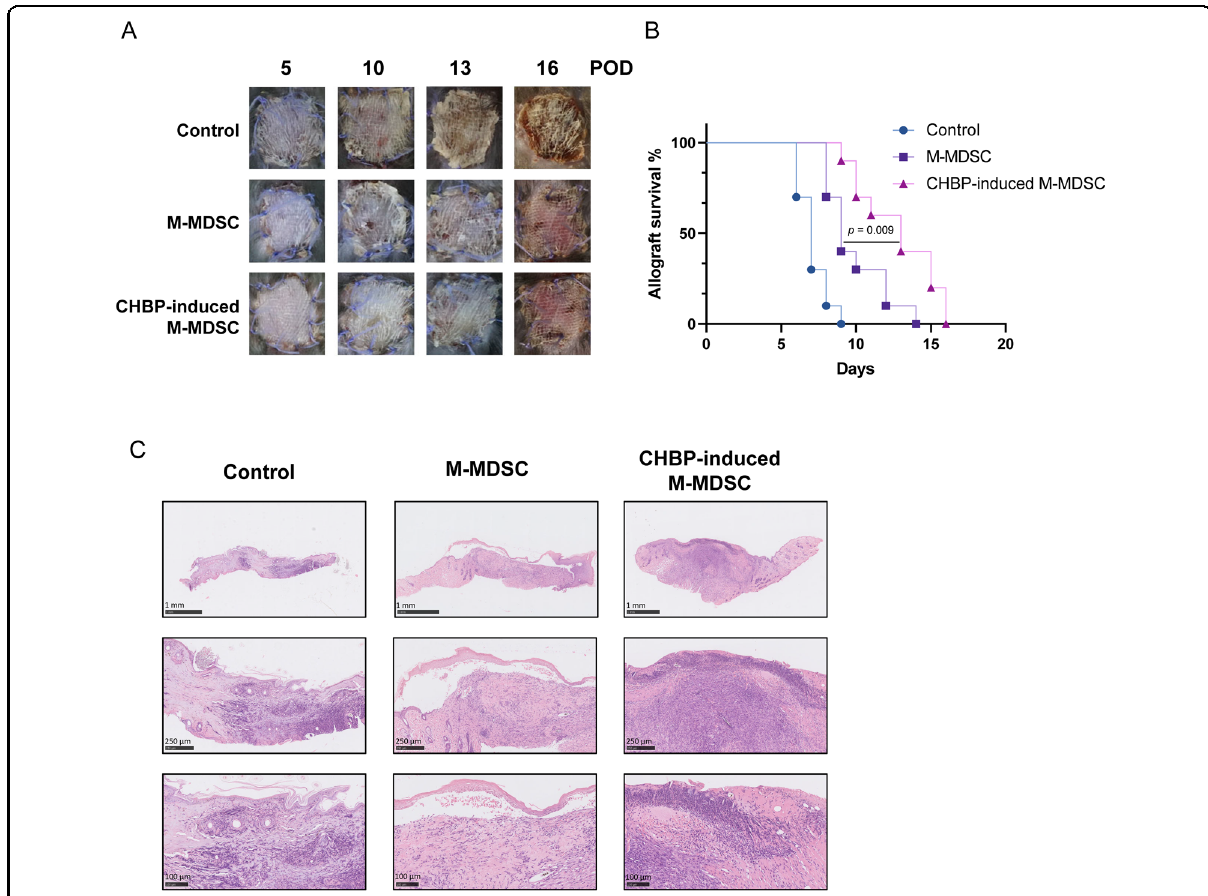
Fig. 2 Infusion of CHBP-induced M-MDSCs prolonged skin allograft survival. A Skin pictures at different days post transplantation. B The survival rates. C H&E staining of the skin (POD 14). Scale bars: 1st row 1 mm, 2nd row 250 μ m, and 3rd row 100 μ